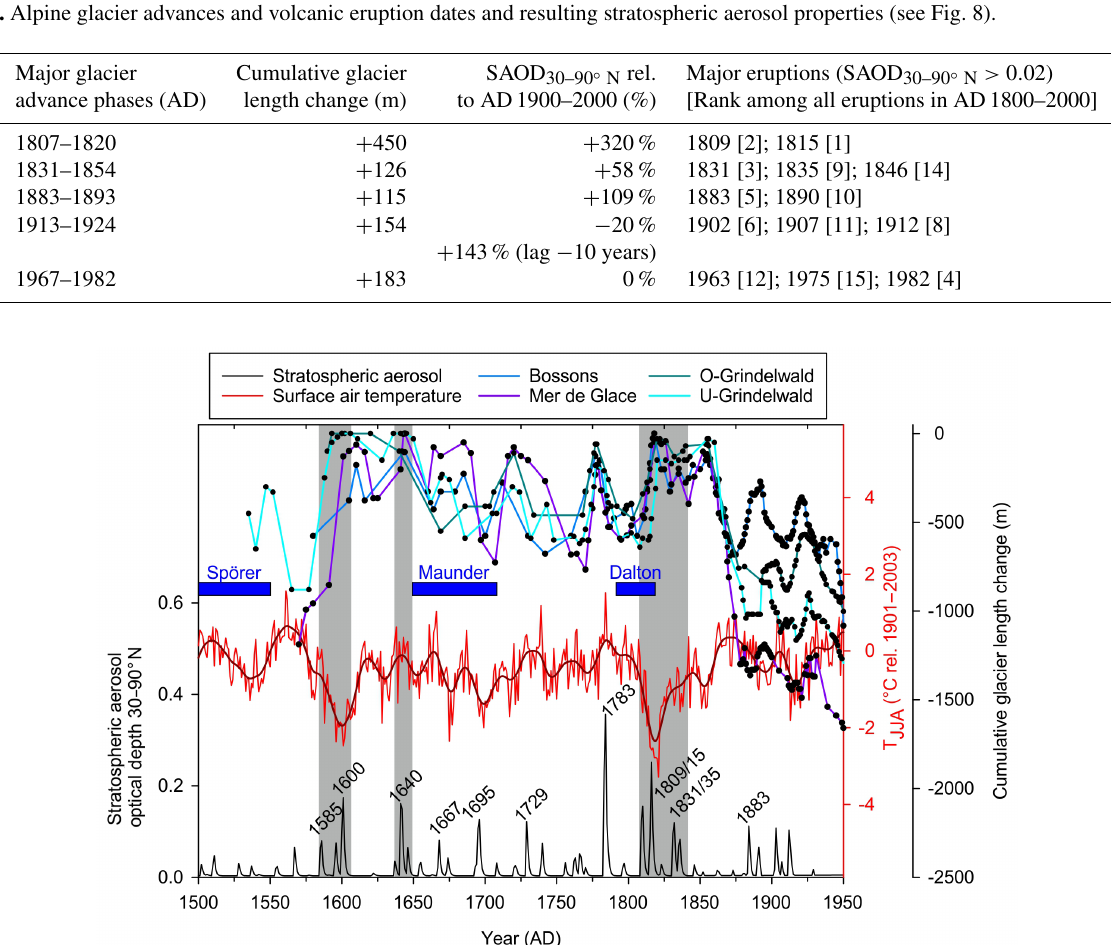
Figure 9. Cumulative glacier length changes for the four glaciers Bossons, Mer de Glace, Oberer (O-) Grindelwald and Unterer (U-) Grindel- wald with black dots marking years with observations (Nussbaumer and Zumbühl, 2012), tree-ring reconstructed Alpine summer (JJA) tem- peratures (Büntgen et al., 2011), minima in solar activity (Usoskin, 2017), and volcanic aerosol forcing (Revell et al., 2017; Toohey and Sigl, 2017) from AD1500 to 1950. Grey shading marks time periods with increased volcanic aerosol